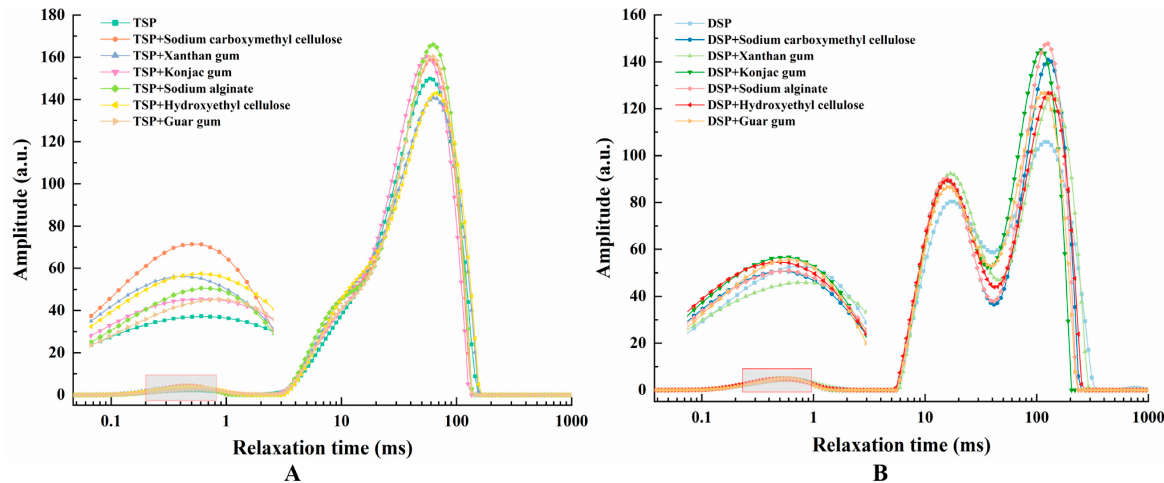
Figure 1. Moisture distribution of composite inks. ( A ) TSP added with different hydrocolloids. ( B ) DSP added with different hydrocolloids.